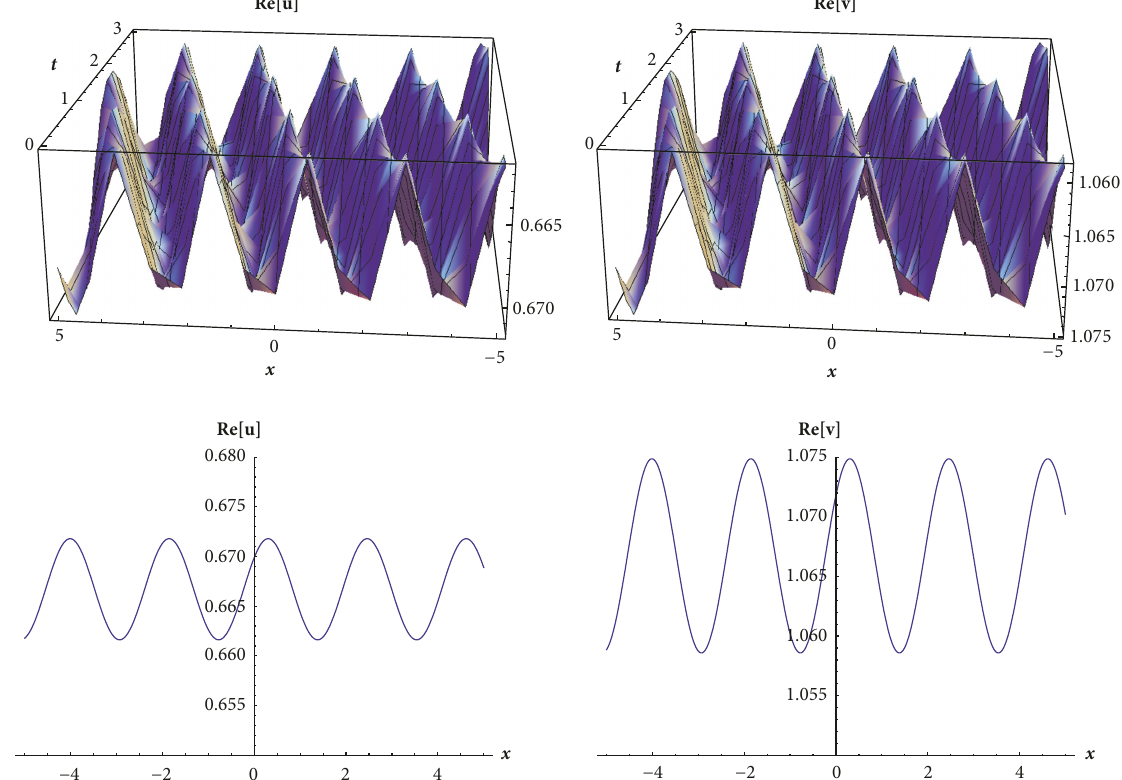
Figure 5: The 3D and 2D surfaces of the analytical solution (26) (real part) by considering the values 𝑏 1 = 0.3 , 𝑎 1 = 0.2 , 𝑘 = 1.6 , 𝑐 = 0.8 , 𝑑 = 0.01 , 𝑦 = 1.5 , 𝜖 = 0.9 , and 𝑡 = 0.007 for 2𝐷